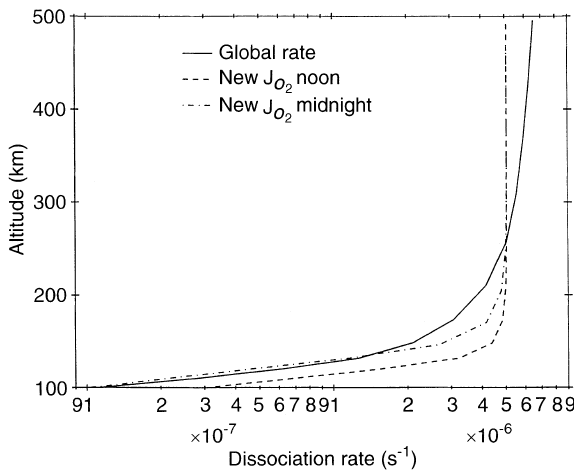
Fig. 4. Altitude profiles of solar heating rates for local noon and local midnight over Argentine Islands. Shown are the rates of Creekmore et al : (1972) and the revised rates, at December solstice